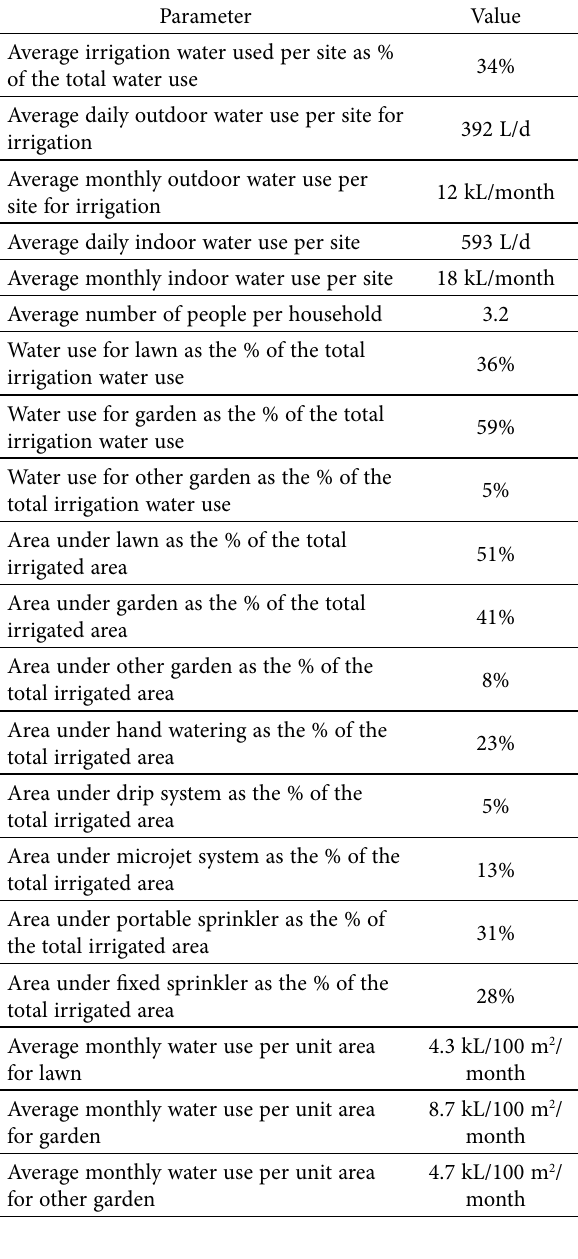
Table 2. Summary of some key results from the study Parameter